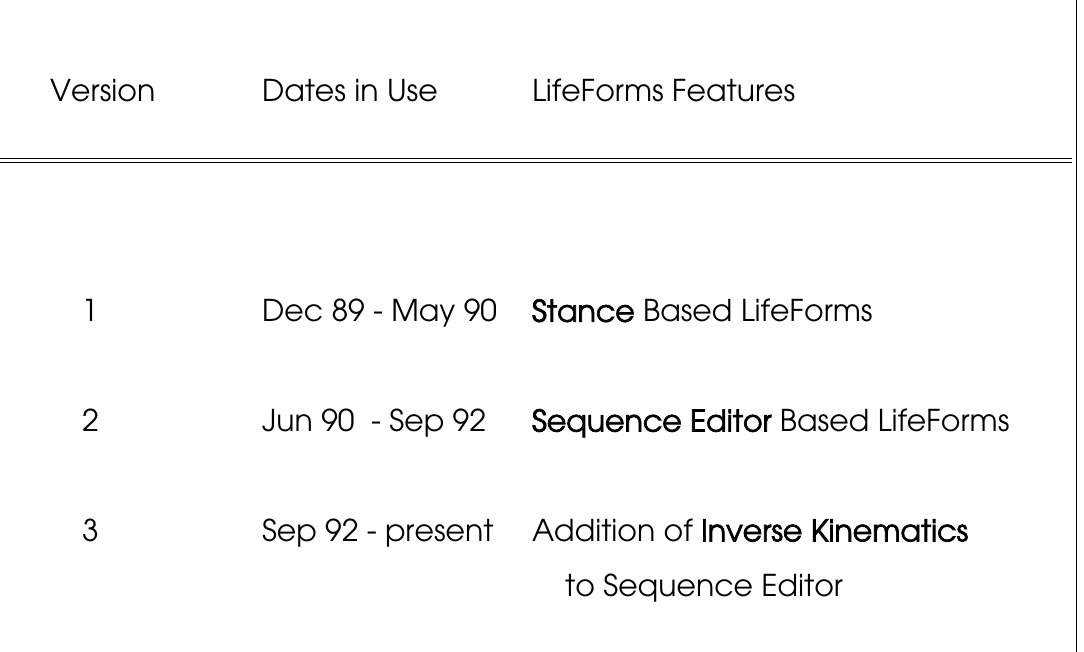
Figure 3.1. LifeForms versions installed in Cunningham’s studio in New